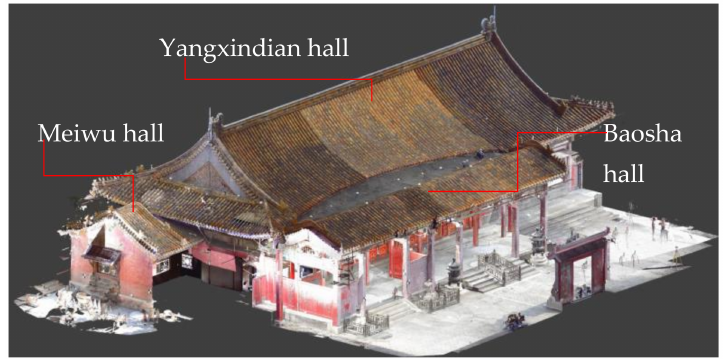
Figure 2. Current status of the three roofs illustrated by the point cloud.